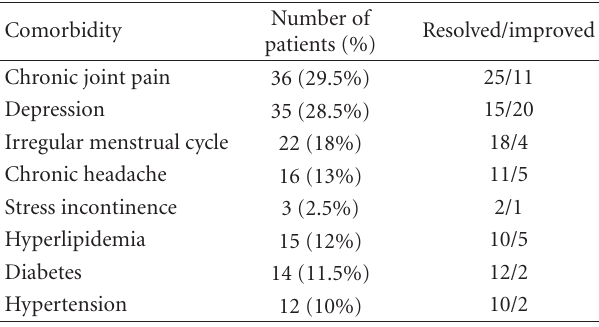
Table 4: Evolution of comorbidities after 6 months of LSG for mildly obese